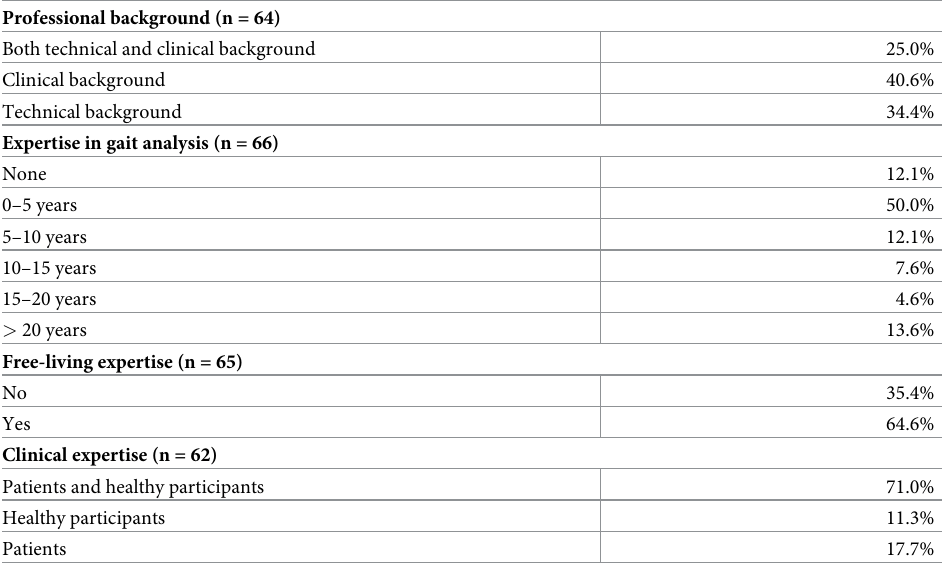
Table 2. Participant background assessed in the first